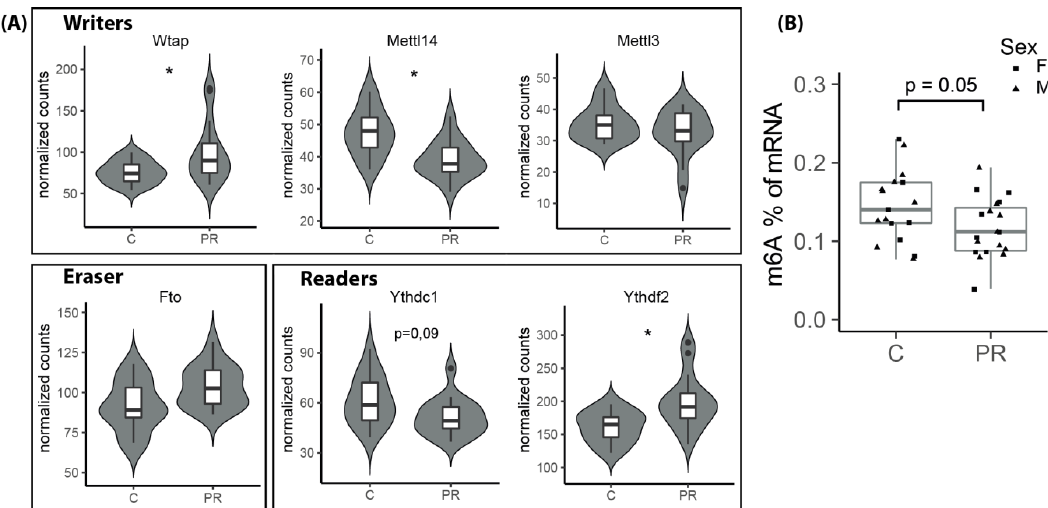
Figure 7. ( A ) Normalized expression level of the genes from the m6A epitranscriptomic machinery obtained using DESeq2 on E17 Hypothalamic RNA sequenced in DGE-seq (PR: n = eight males + eight females, C: n = eight males + eight females) (adjusted p -value from Deseq2 analysis: * padj < 0.05). ( B ) Quantification of the percentage of m6A in total RNA from E17 fetal hypothalamus using m6A immunodetection assay (PR: n = 10 males + nine females, C: n = 10 males + seven females) (two-way ANOVA group effect p = 0.05, sex effect p = 0.73) (boxplot: median, first and third quartiles).